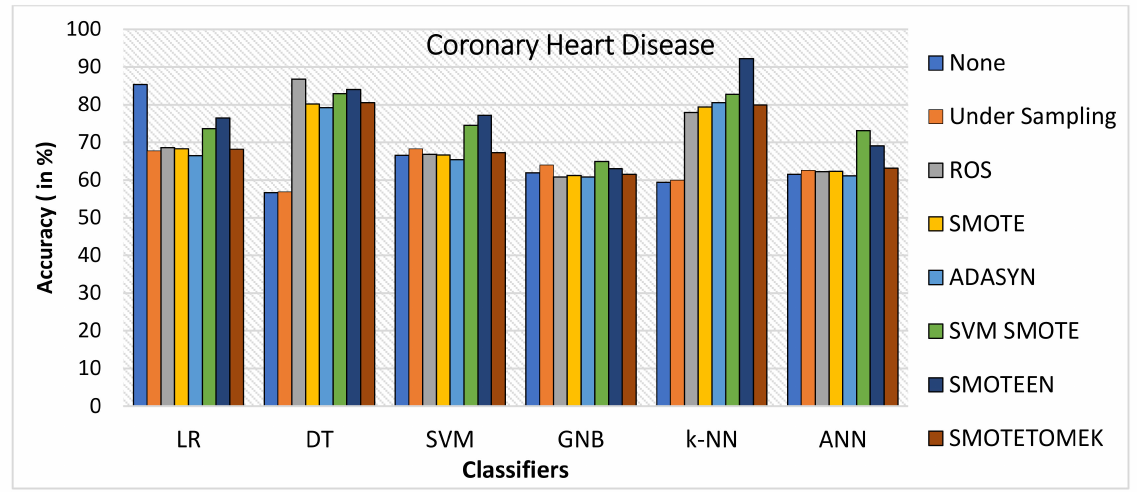
Figure 18. Accuracy for coronary heart disease dataset of balancing algorithms over six classifiers.